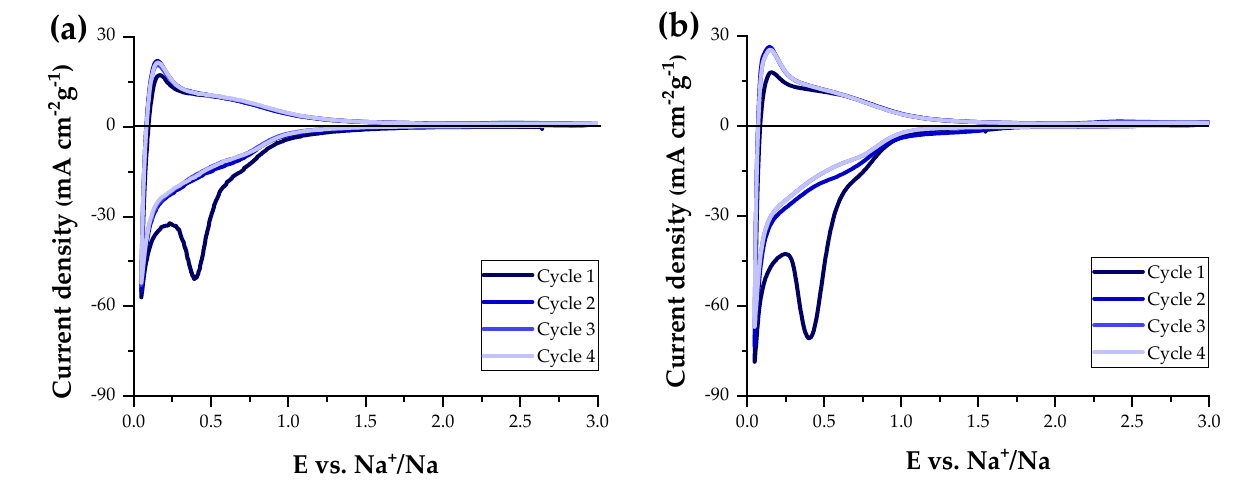
Figure 5. Cyclic voltammetric profiles of C-surgical ( a ) and of C-FFP2 ( b ) in 1 M NaClO 4 in PC recorded at a scan rate of 0.1 mV s − 1 in the 0.05–3 V vs. Na + /Na range.